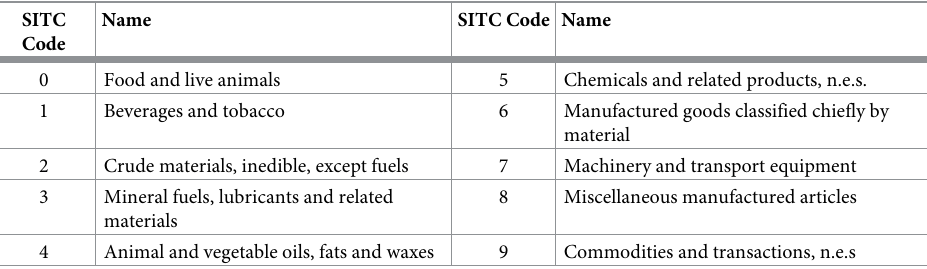
Table 1. Sectoral decomposition used in the